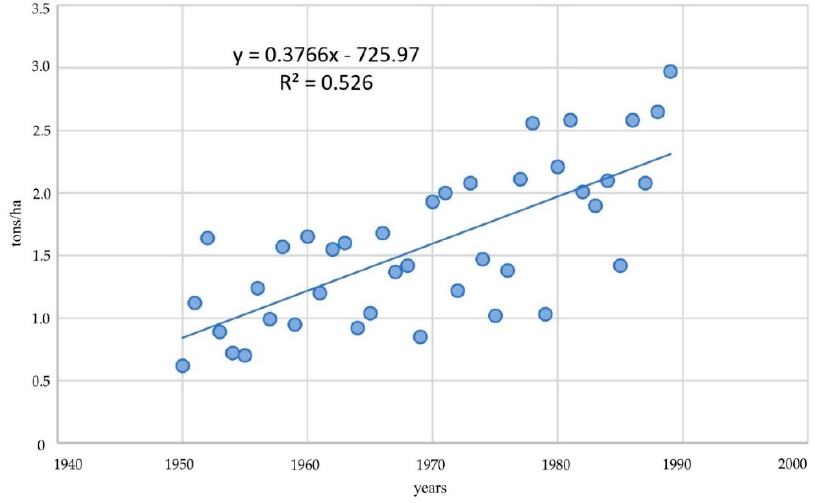
Figure 4. Winter wheat yields in 1950–1990, tons/ha. Source: authors’ development based on [121,122].